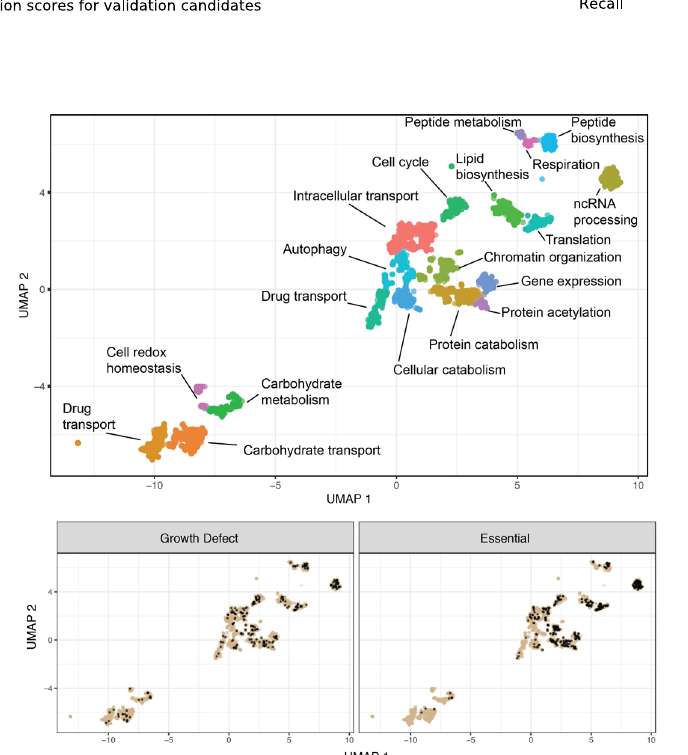
Fig. 2 Testing the accuracy of the prediction model with the GRACEv2 collection. a Distribution of prediction scores for the 98 experimentally con fi rmed essential genes and 768 non-essential genes from the validation candidates (GRACEv2 strains). b Precision-recall curve of the random forest model derived from the whole GRACE set and tested on the GRACEv2 experimental validation set. The default stringent cutoff score for essential gene predictions results in a precision of 0.64 and a recall of 0.76, with an average precision score of 0.66. c Essential genes are enriched in speci fi c functional clusters. Clusters were generated by UMAP embedding of co-expression and functional enrichment was determined by GO term analysis. Source data are provided as a Source Data fi